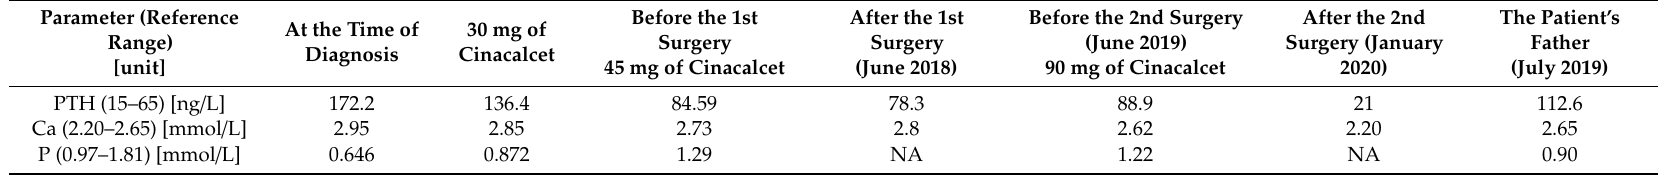
Table 1. Results of the patient’s laboratory tests from the time of diagnosis until the most recent assessment, and the lab results of the patient’s father at the time of